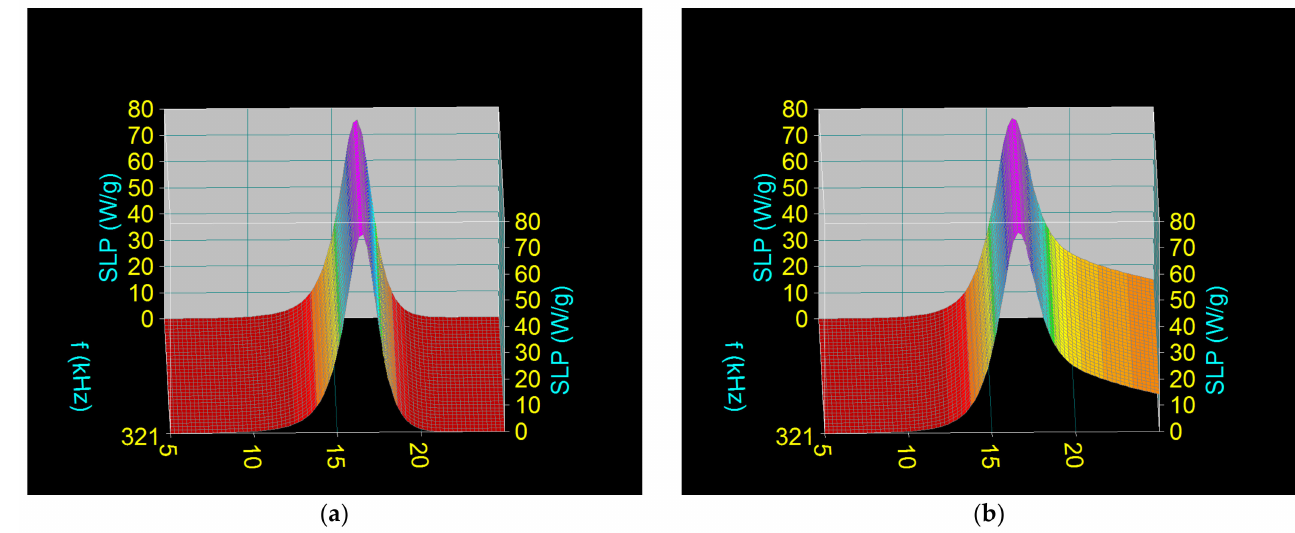
Figure 4. Relaxation contributions to the specific loss power for 321 kHz and 16 kA/m magnetic field: ( a ) N é el relaxation in the case of fixed Fe 3 O 4 -PAA–(HP- γ -CDs) nanobioconjugates, and ( b ) N é el– Brown relaxations in the case of mobile Fe 3 O 4 -PAA–(HP- γ -CDs)